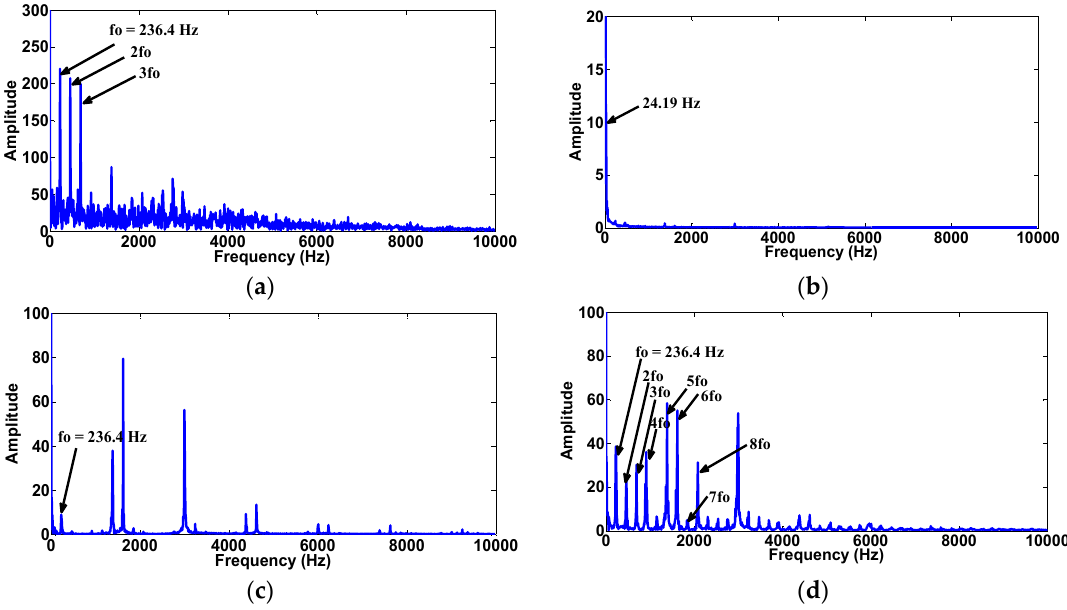
Figure 10. Time ‐ domain waveform of the de ‐ noised serious outer race fault in bearing 1: ( a ) De ‐ noised signal by MMBDSOICE; ( b ) De ‐ noised signal by MMBCSOICE; ( c ) De ‐ noised signal based on MPODSOISE; ( d ) De ‐ noised signal based on MPOCSOISE.